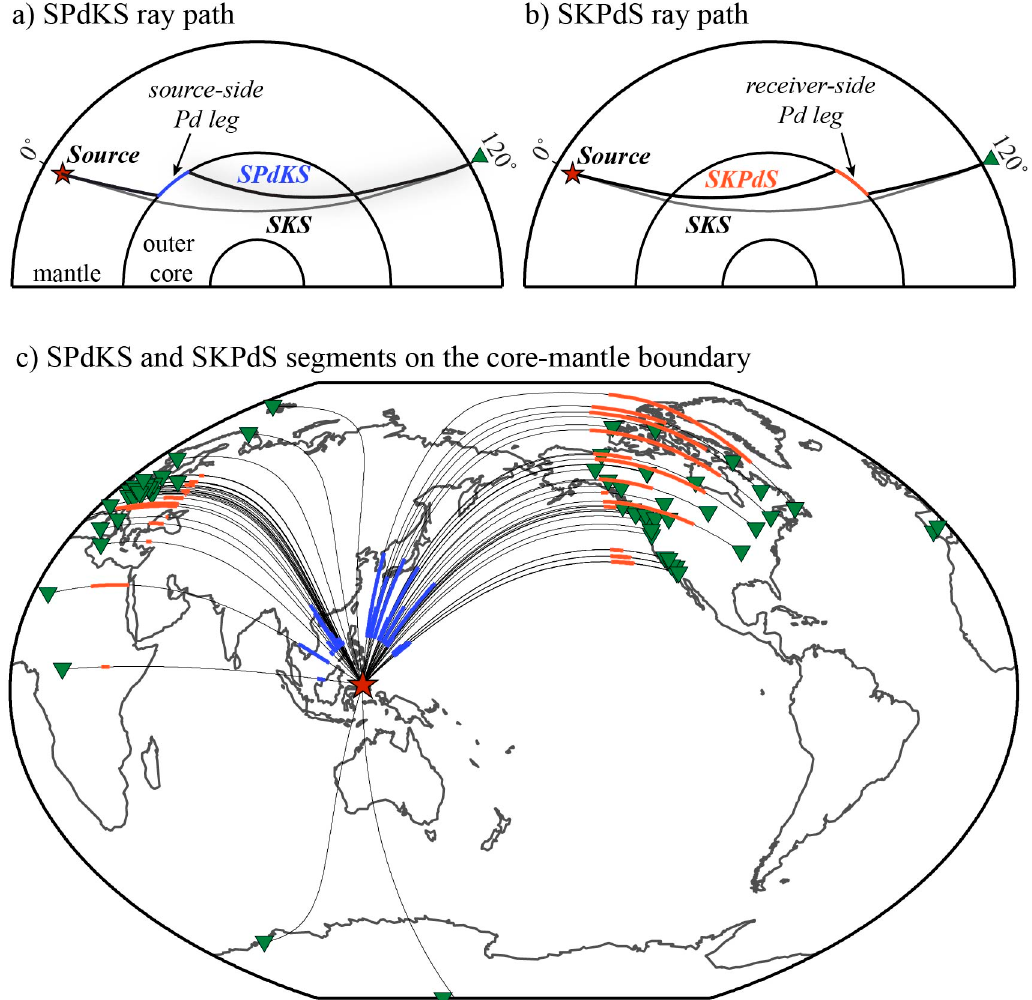
Figure 1. ( a ) Ray path for SKS (black) and SPdKS (blue) for a receiver located at an epicentral distance of 120°. ( b ) Ray path for SKS (black) and SKPdS (orange). In (a) and (b), the Pd portion of the ray path is indicated. ( c ) Example Pd legs projected onto the core–mantle boundary (CMB) are shown for an event occurring on 28 February 1996. The source-side (SPdKS) Pd legs are drawn in blue and the receiver-side (SKPdS) Pd legs are drawn in orange. The great circle path connecting source and receiver is drawn with solid black lines. In all panels the earthquake source is drawn with a red star and the receiver locations are shown with inverted green triangles.